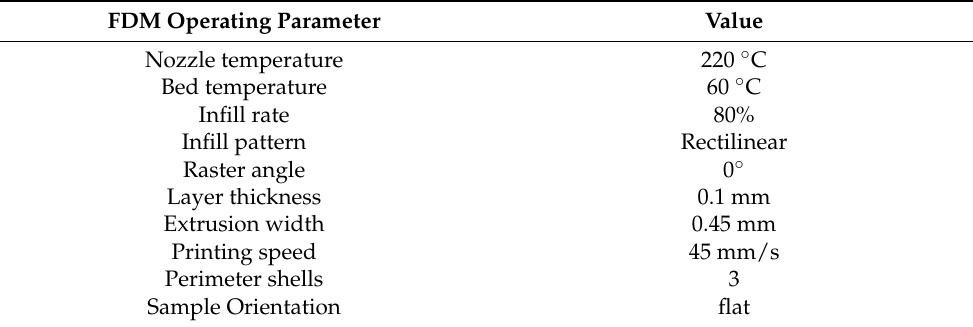
Table 1. FDM process parameters adopted in this